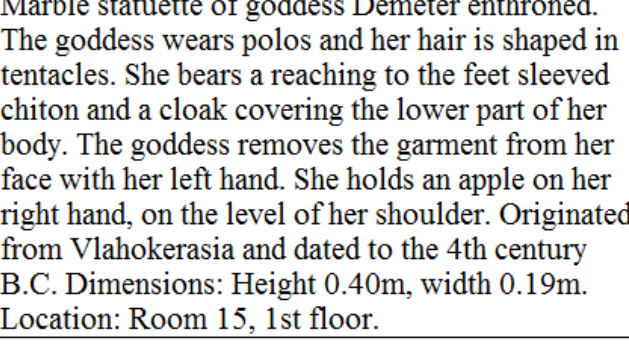
Figure 4. Textual description of an exhibit (PoI).